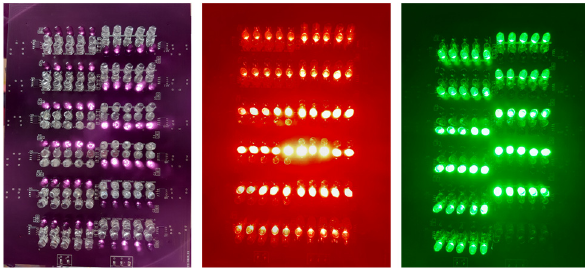
Figure 8. Illumination device switched on: infrared, red, and green light.